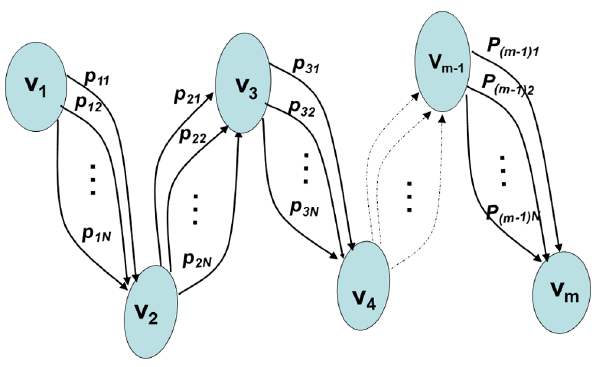
Figure 1. Graph for the Solution Construction Mechanism.